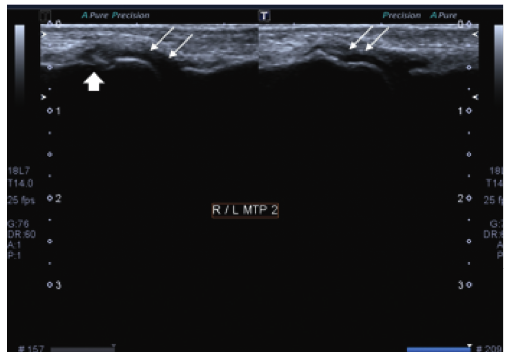
Figure 7: Grayscale images of bilateral 2 nd metatarsophalangeal joint demonstrating moderate synovial thickening (white arrows). The findings are consistent with Grade 2 synovitis. There is subtle irregularity seen in the bony cortex of the underlying bone on the right side suggesting erosions (block